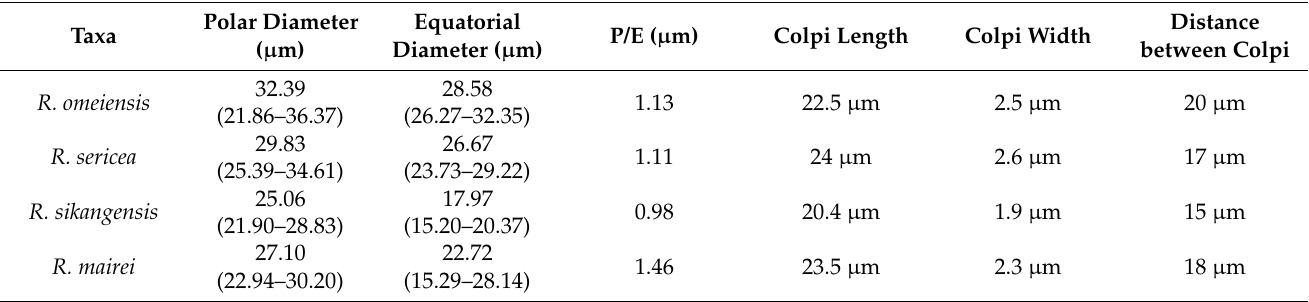
Table 3. Quantitative characteristics of pollen of R. sericea complex